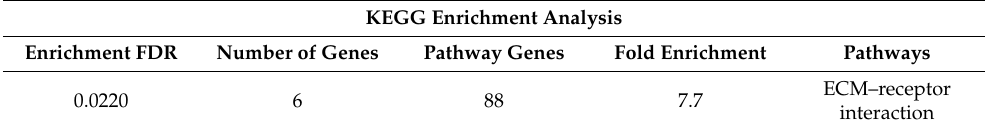
Table 3. Significant pathways identified after KEGG Enrichment Analysis. FDR; False discovery